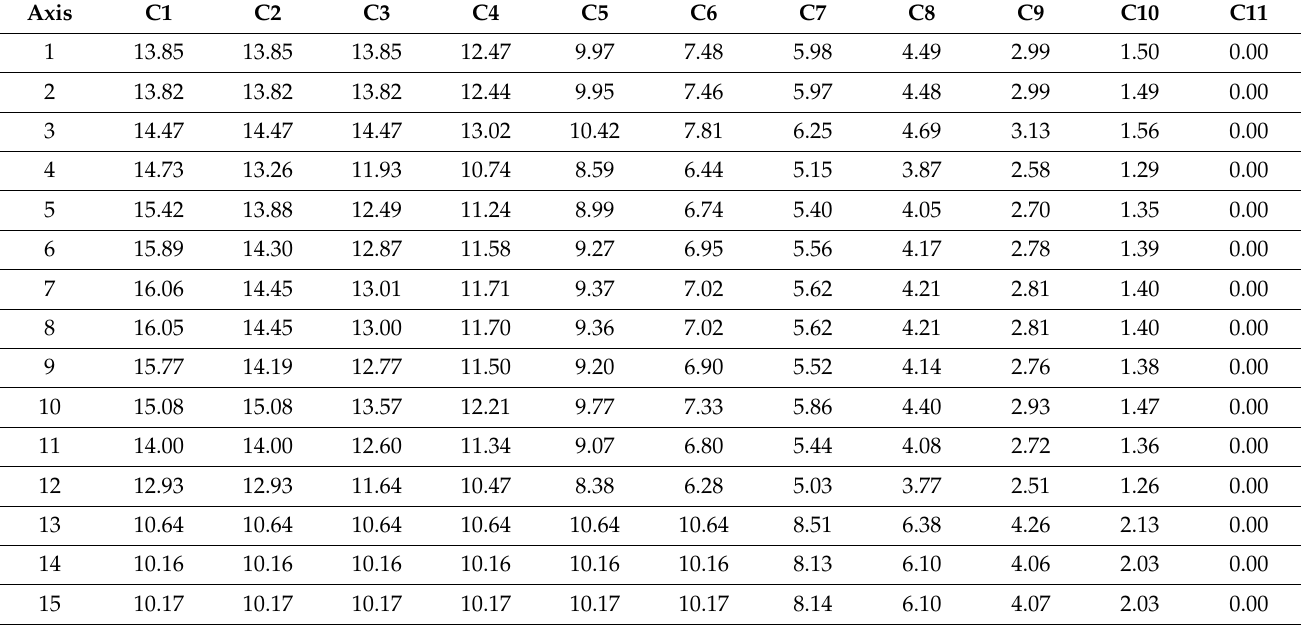
Table 11. Length of traction cables under various calculation conditions (m).